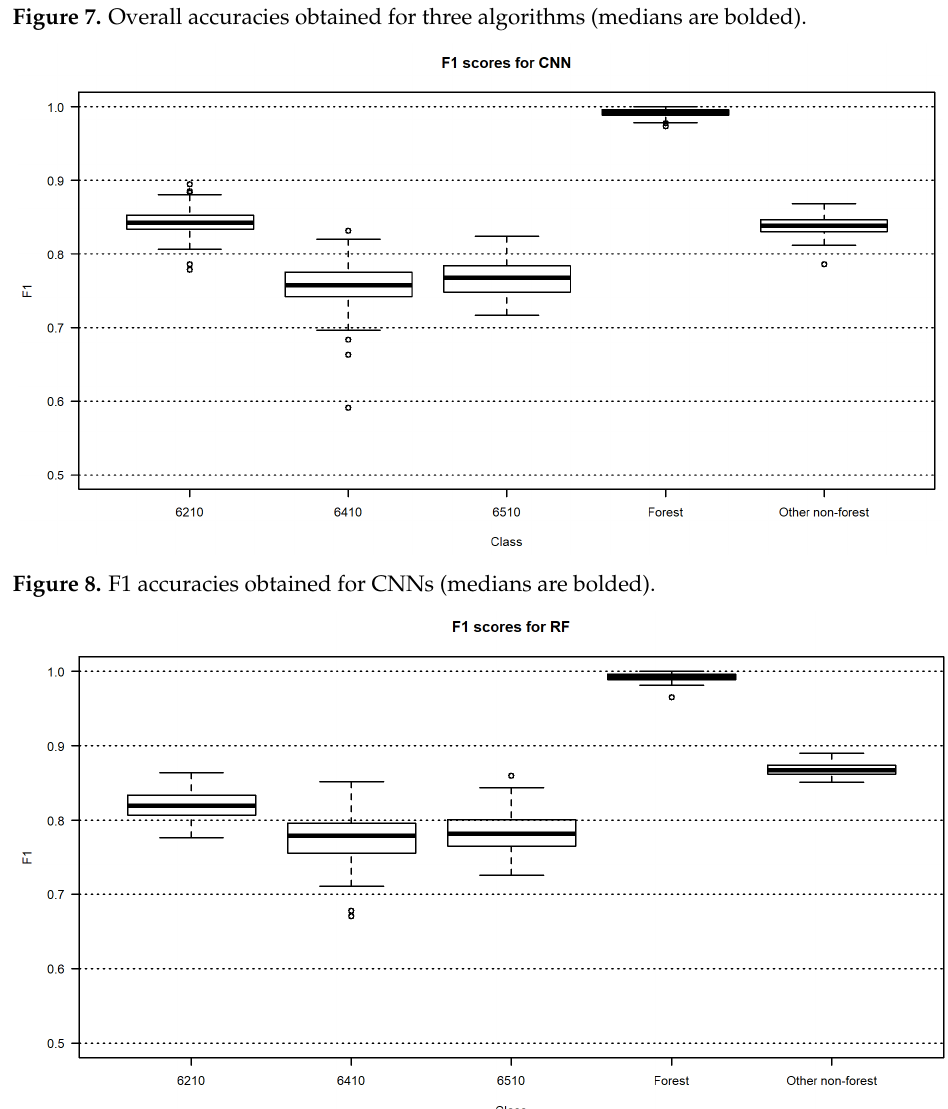
accuracy for each habitat and background class. Boxplots with bolded median values be-